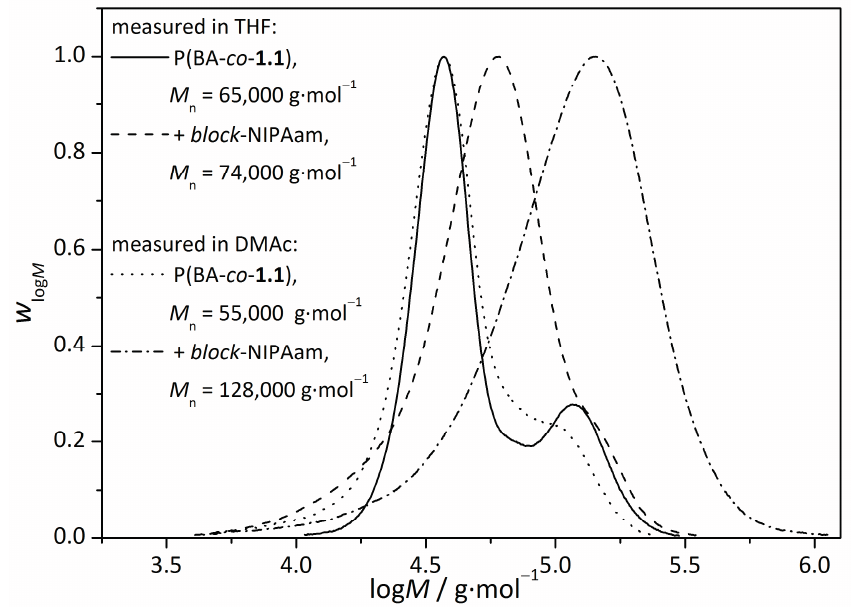
Figure 5. Molecular weight distributions—size exclusion chromatography (SEC)-data—of a macroRAFT agent starpoly (BA- co - 1.1 ) and the resulting starpoly [(BA- co - 1.1 ) 44 - block - NIPAam 56 ] sample of the polymerization c macroRAFT = 0.3 mmol·L − 1 , c AIBN = 0.7 mmol·L − 1 and c NIPAam = 1.290 mmol·L − 1 in chloroform at 60 °C after 180 min, measured in tetrahydrofuran (THF) and N , N -dimethyl acetamide